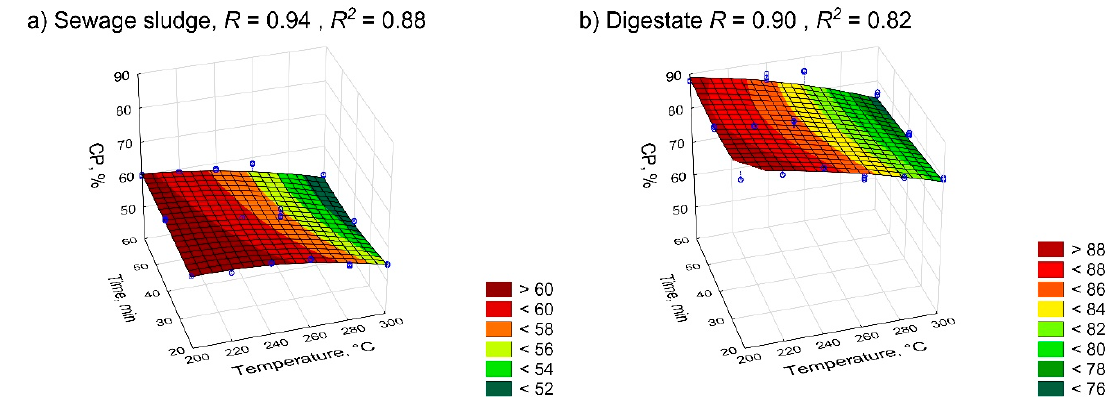
Figure 9. The influence of torrefaction temperature and residence time on combustible parts in CSF from ( a ) sewage sludge and ( b ) digestate. R —correlation coefficient; R 2 —determination coefficient.